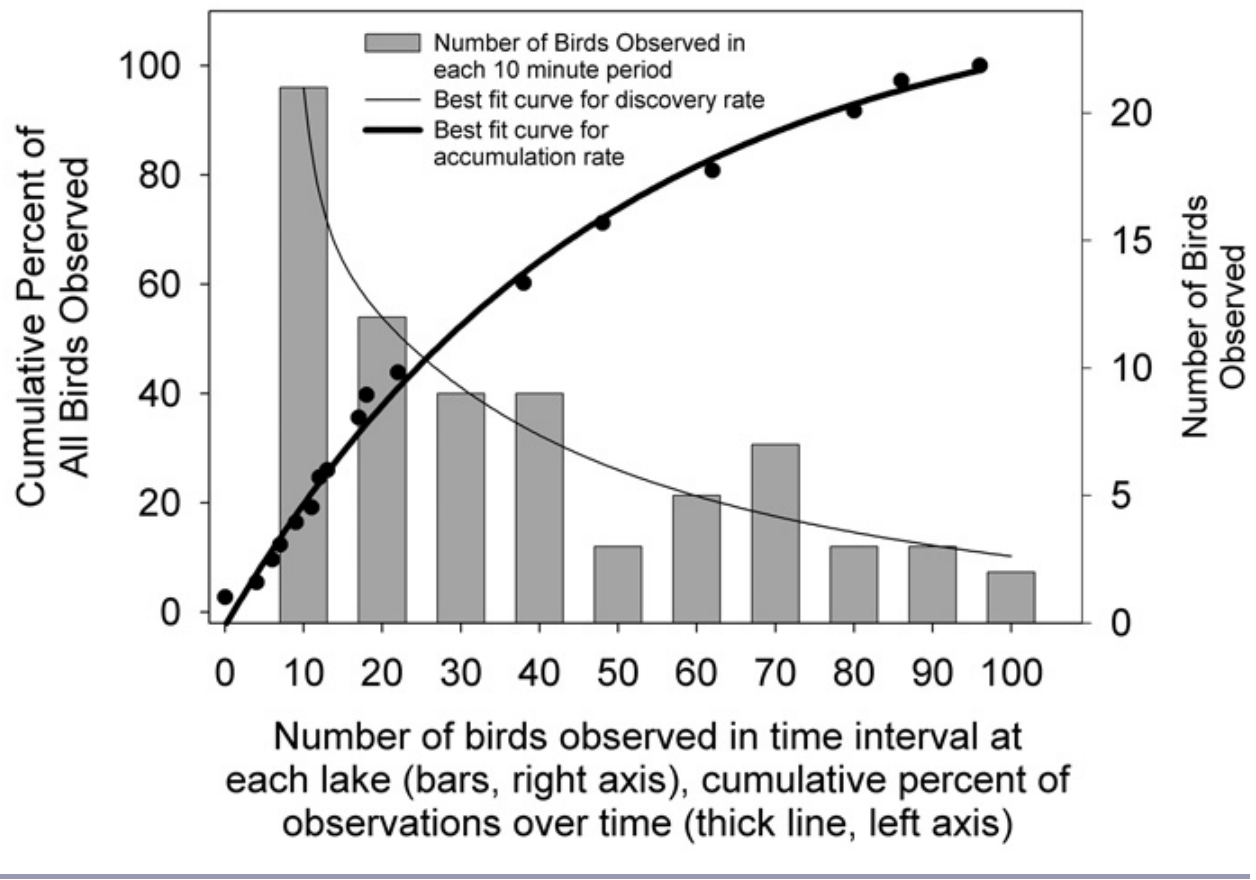
Fig. 3. Time to the first detection of Rusty Blackbirds at each lake is represented by bars compared to both the total number of observations over time and the cumulative percent of observations. Bars are at the end of the time interval, so the first bar is the 0–10 min interval, then 10–20 min, etc. Half of all birds observed were seen within 30 min from the start of a survey. The longest time to detect the first bird at a lake was 96 min. The best fit line for declining discovery rate had R 2 = 0.93 and had y = 0, i.e., no birds expected, at 265 min. The best fit line for accumulation rate had R 2 = 0.995 and reached a maximum value of 83.7 birds. Equations and constants are provided in the